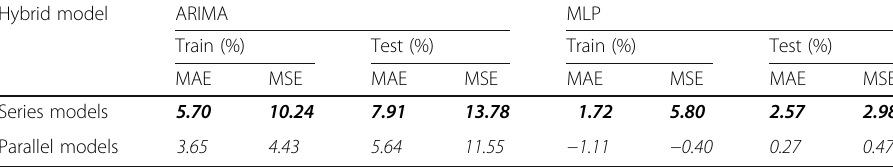
Table 6 Average improvement in series and parallel models over ARIMA and MLP models for SZII Hybrid model